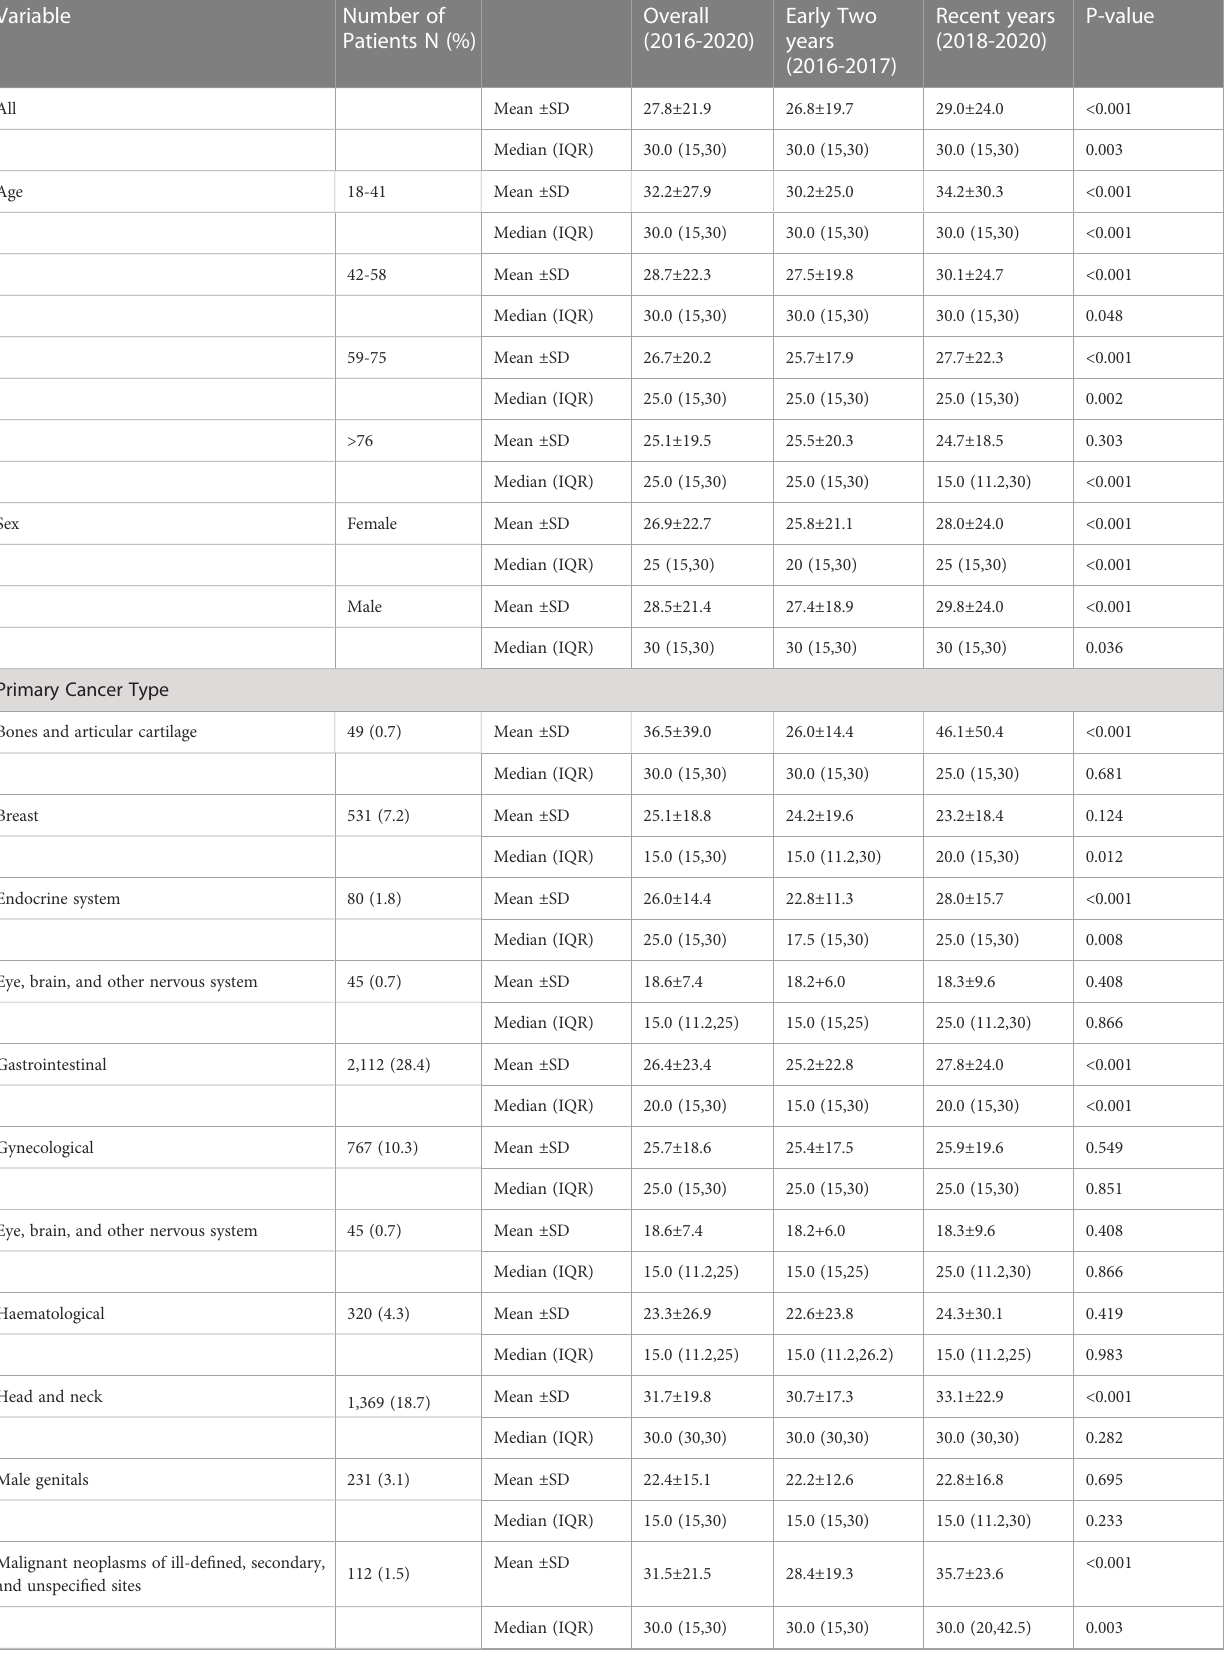
TABLE 2 Distribution of MEDD by cancer type, staging, and metastasis during 2016 – 2020 (N=